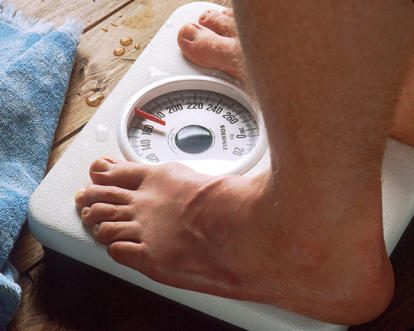
Scientists believe that genetic mutations in a specific region in Chromosome 10 play a role in obesity and have studied one gene, GAD2, intensively. But a new study finds no evidence linking GAD2 mutations with obesity